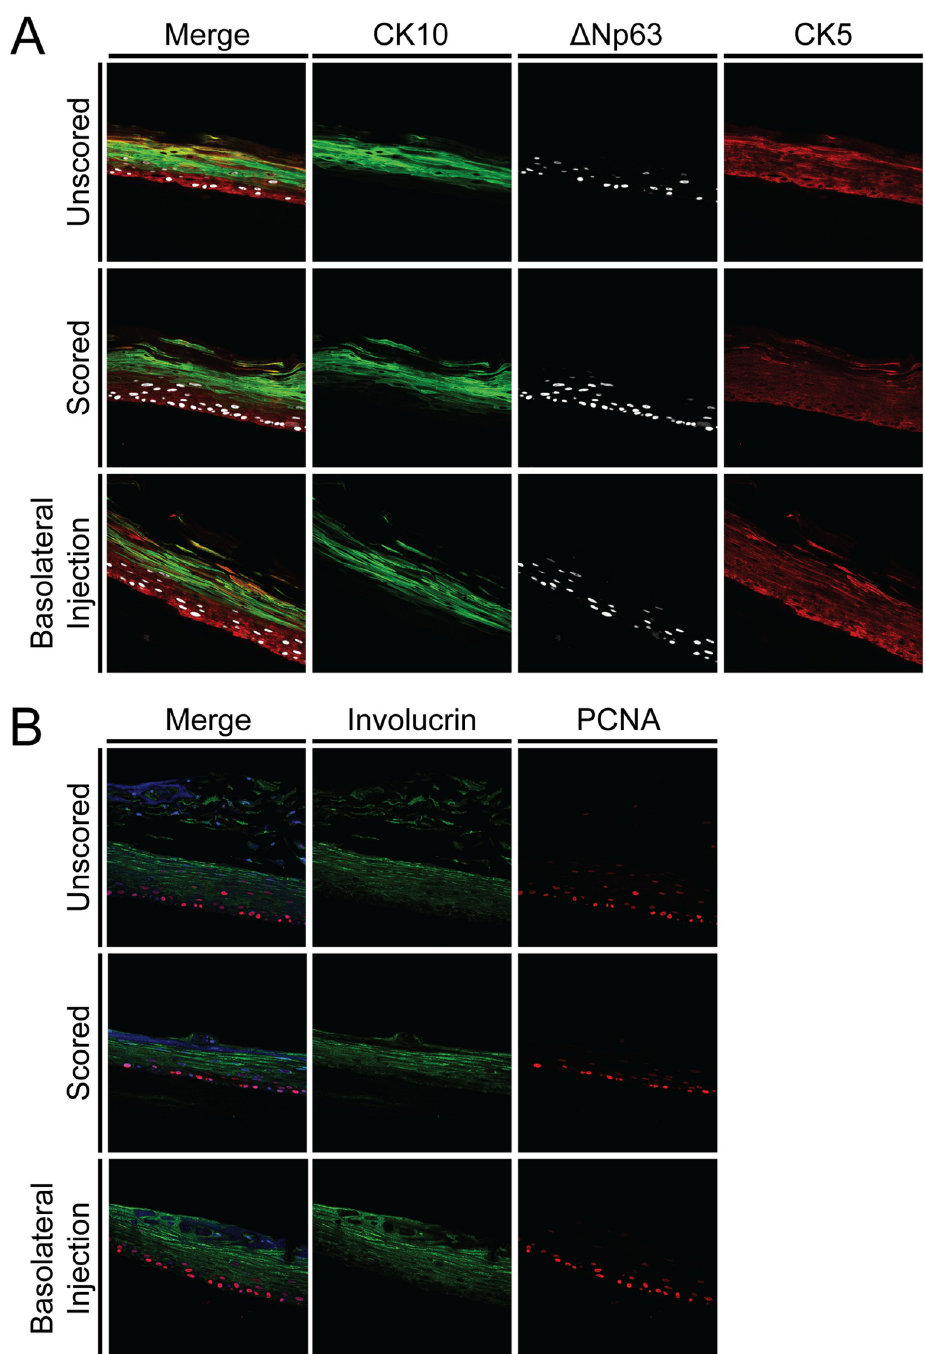
Fig 4. Differentiation of organotypic cultures is not affected by scoring tissue or basolateral infection. Organotypic cultures were collected at 9 days of growth and stained for a variety of differentiation markers. (A) Cytokeratin 10 (CK10) was expressed in the upper layers of the epithelium, while Δ Np63 expression was detected in the lower layers of the epithelial model. Cytokeratin 5 (CK5) was expressed in all epithelial cells. (B) Involucrin was detected in all but the bottommost layer of the epithelium. PCNA was detected in several of the lower layers of the epithelium.